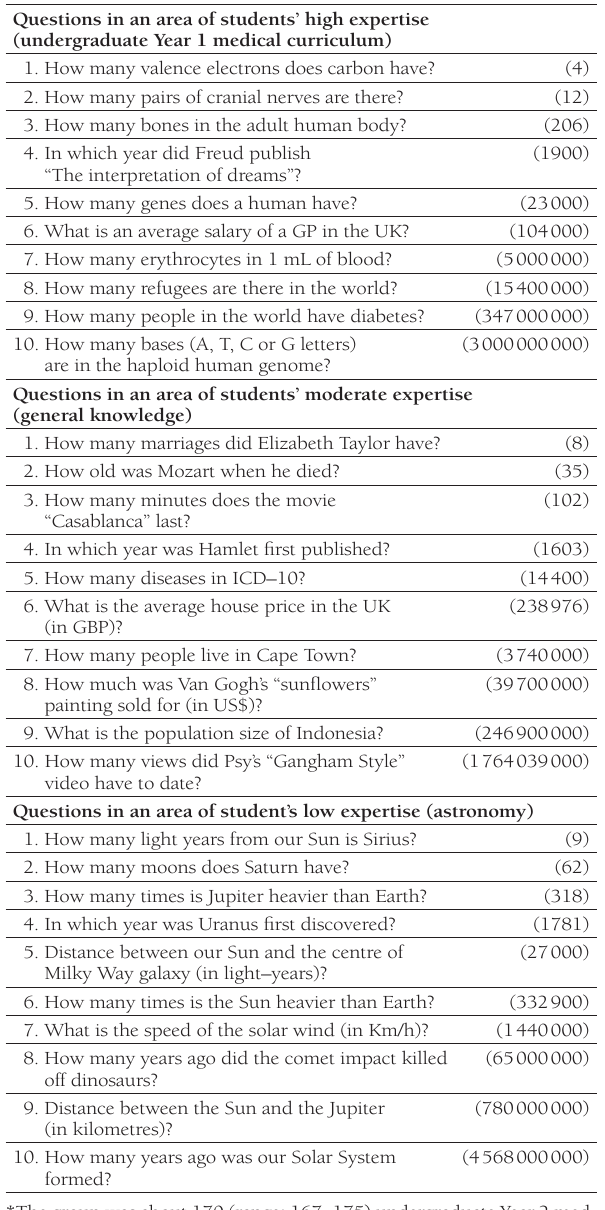
Table 1. Questions posed to a group of undergraduate Year 2